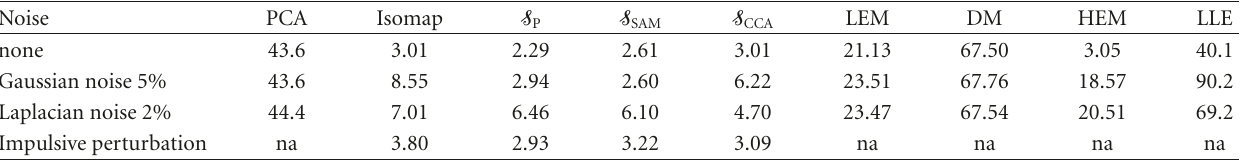
Table 1: Distances between the original reduced coordinates and the estimated ones for a 2000-point SCurve. For S CCA , the threshold was set so that 5% of the lowest distances d 2 were considered. LEM, DM, HEM, and LLE stand for Laplacian eigenmap, di ff usion map, Hessian eigenmap, and locally linear embedding, respectively. In the cases of rows 3 and 4 (Gaussian and Laplacian noise), noise is a ff ecting the coordinates of the y i ’s. The noise variances (2% and 5%) are quantified with respect to the variance of the noise-free data. In case of row 5, the distances d 1 are perturbated with a Laplacian noise a ff ecting 12 . 5% of the d 1 ’s. The noise variance (200%) is quantified with respect to the variance of the noise-free d 1 − d 2